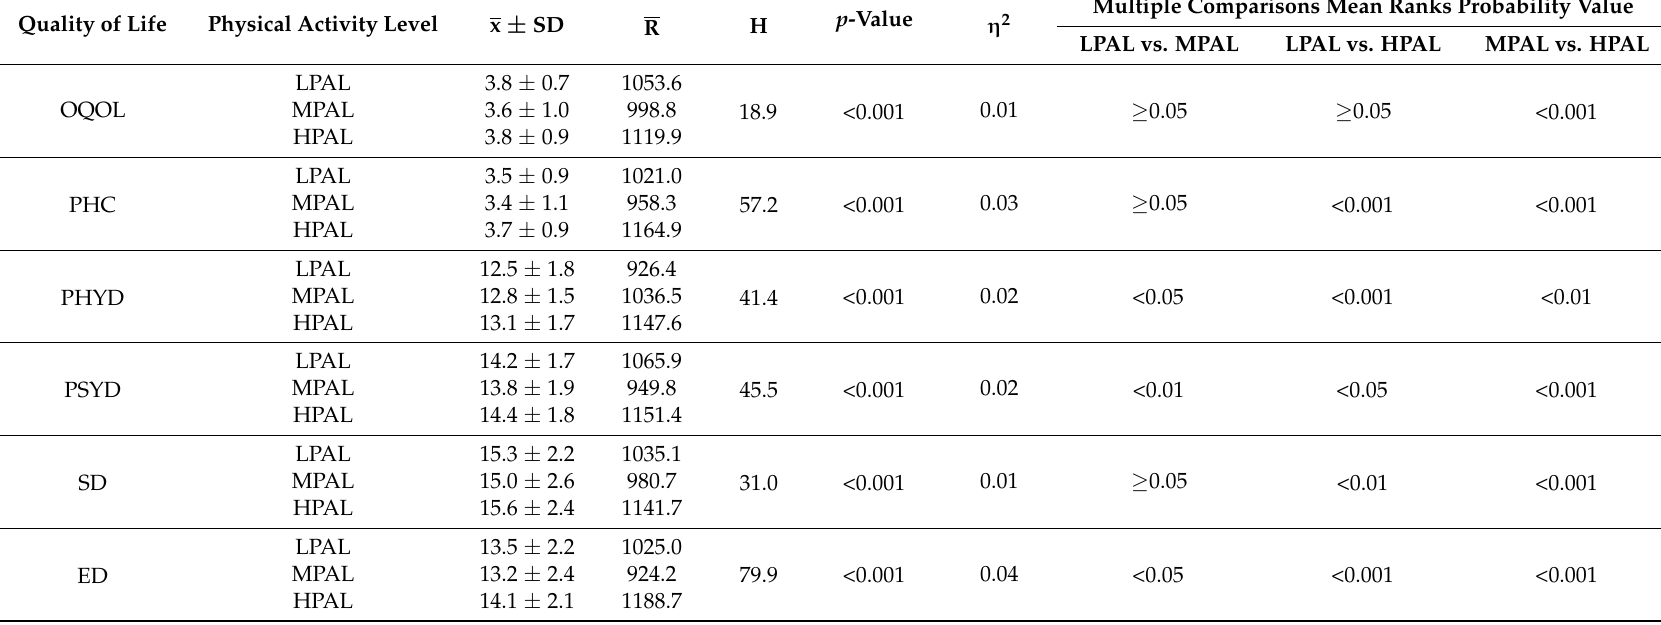
Table 2. Quality of life in groups of men with different levels of physical